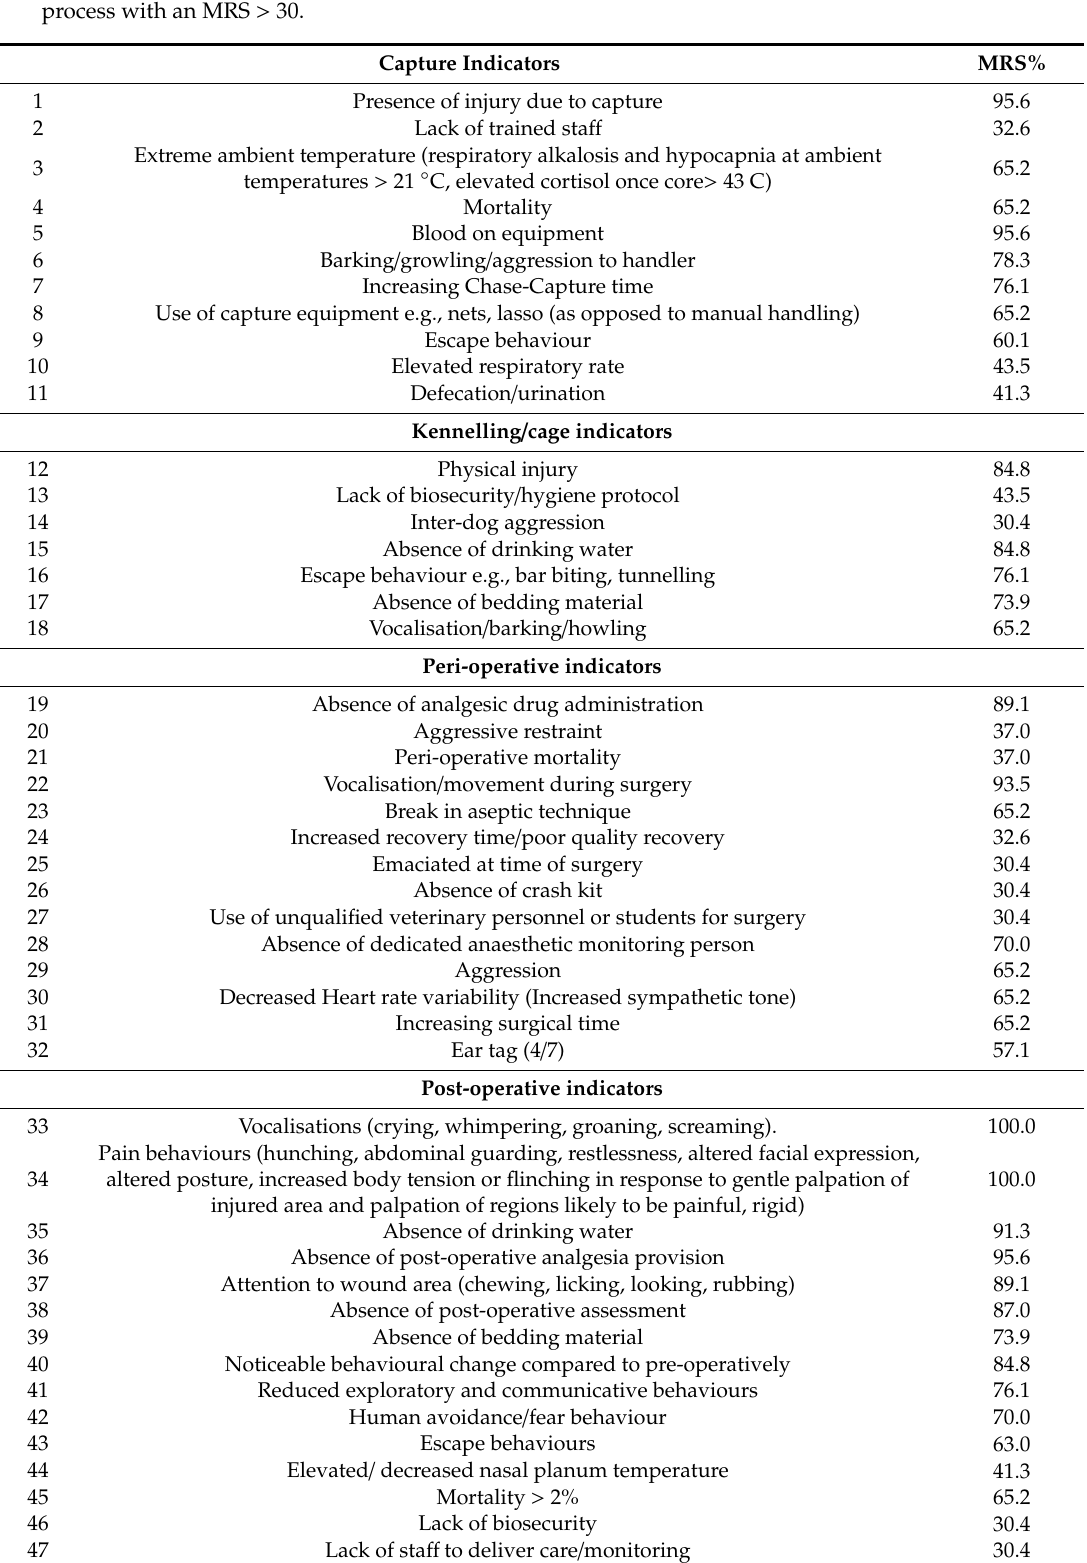
Table A1. Table of 53 dog welfare indicators and hazards generated by the literature review and Delphi process with an MRS >